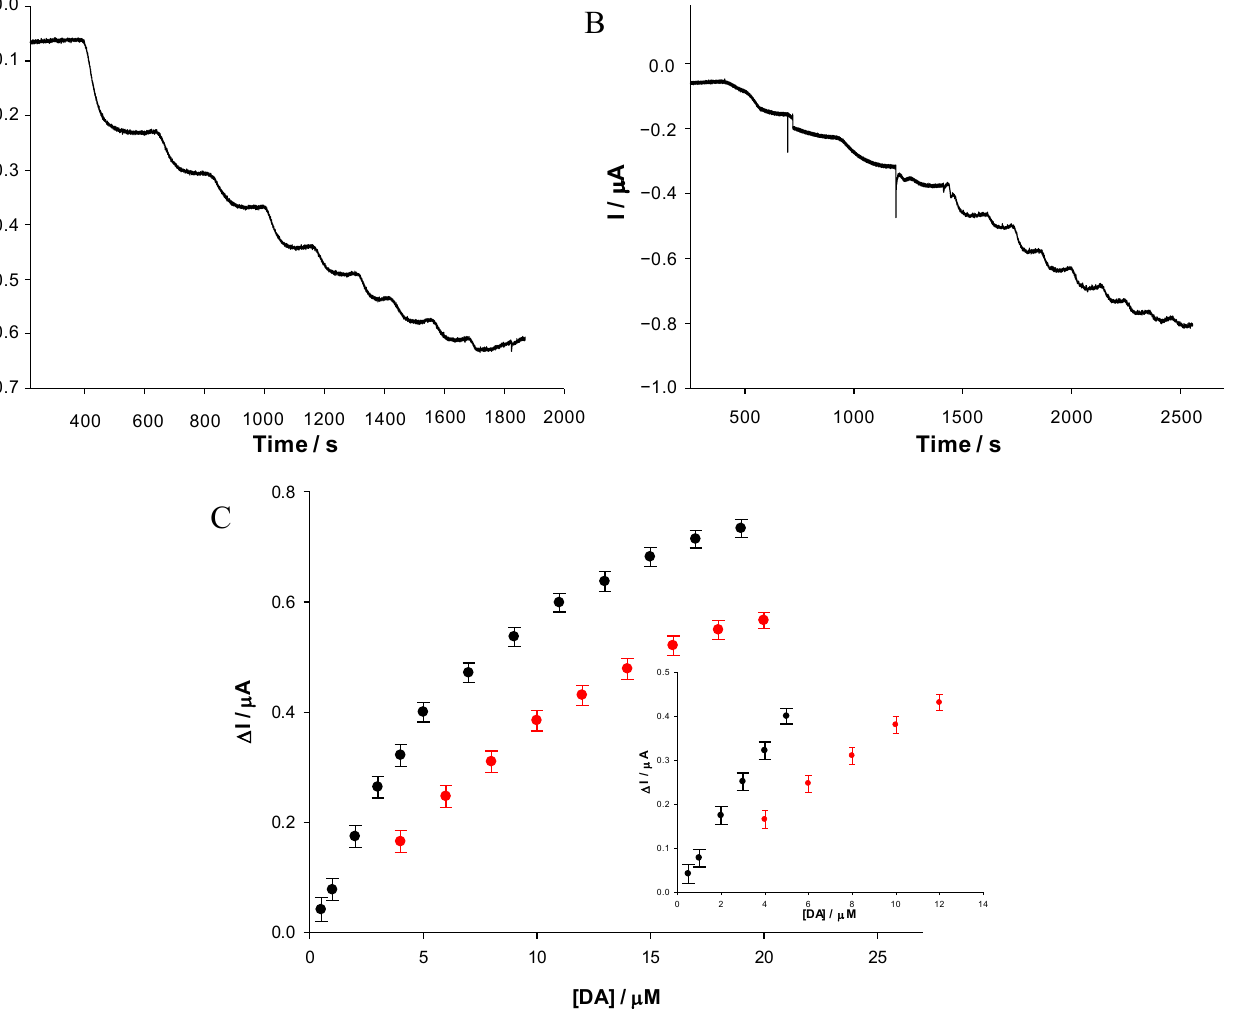
Figure 6. Typical chronoamperometric curves of Tyr/ChitNPs/GPH/SPE (Panel A ) and Tyr/EDC- NHS/ChitNPs/GPH/SPE (Panel B ) upon successive additions of different concentrations of DA to the stirred PBS (0.1 M, pH 7.2, KCl 0.1 M) (applied potential: 0 V vs. Ag/AgCl) and the relative calibration curves of Tyr/ChitNPs/GPH/SPE (Panel C , red curve) and Tyr/EDC- NHS/ChitNPs/GPH/SPE (Panel C , black curve) as a function of DA concentration. Inset: the magnification of the linear